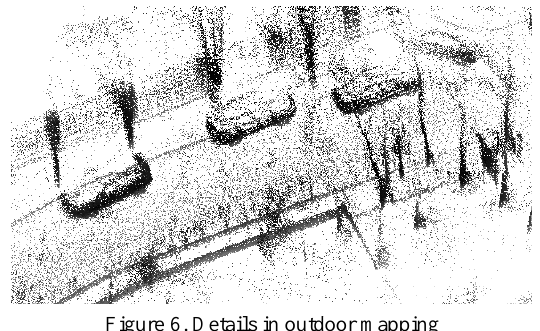
Figure 6. Details in outdoor